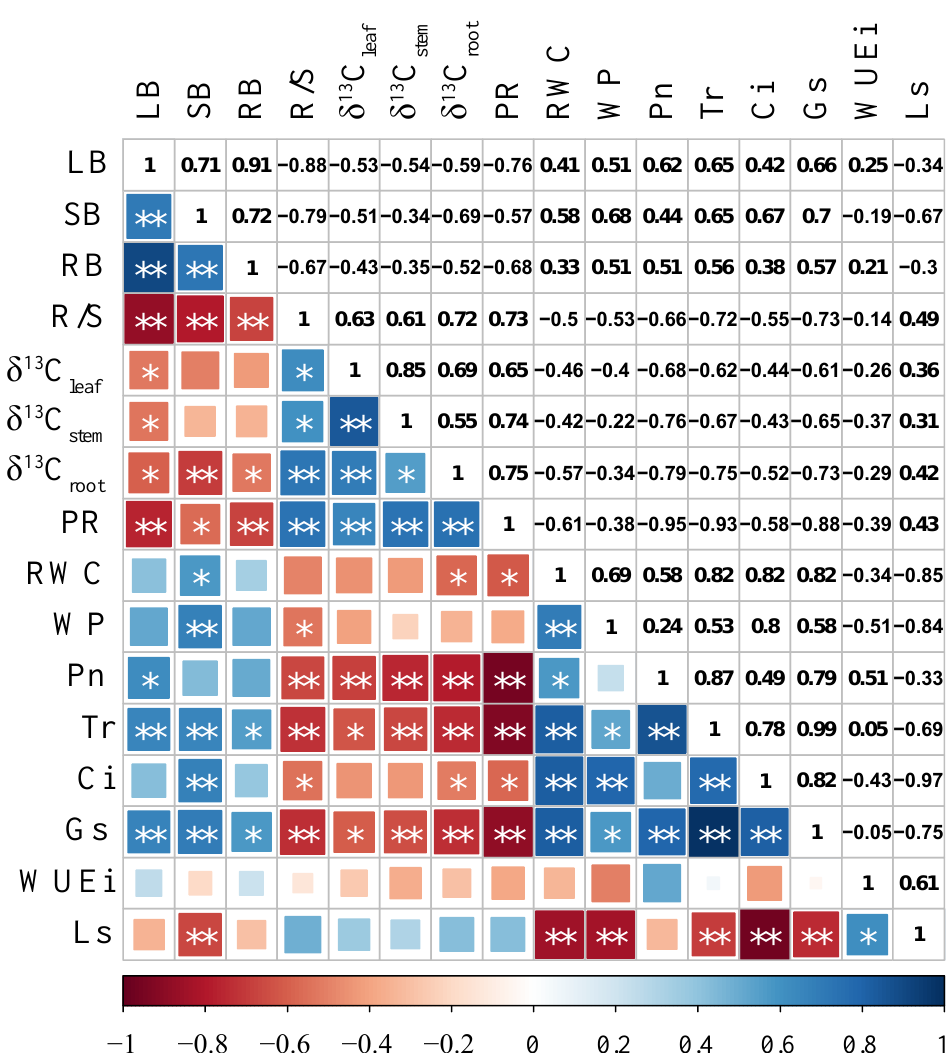
Figure 6. Correlation coefficient between different organ biomasses and related physiological indexes of Glycyrrhiza uralensis . δ 13 C leaf , δ 13 C stem, and δ 13 C root represent the δ 13 C values of leaf, stem, and root; LB, SB, and RB represent the leaf biomass, stem biomass, and root biomass; R/S, PR, RWC, WP, Pn, Tr, Ci, Gs, WUEi, and Ls represent the root to shoot ratio, proline, relative water content, water potential, net photosynthetic rate, transpiration rate, intercellular CO 2 concentration, stomatal conductance, instantaneous water use efficiency, and limiting value of stomata, respectively. * and ** indicate significant correlation at 0.05 and 0.01 levels, respectively.